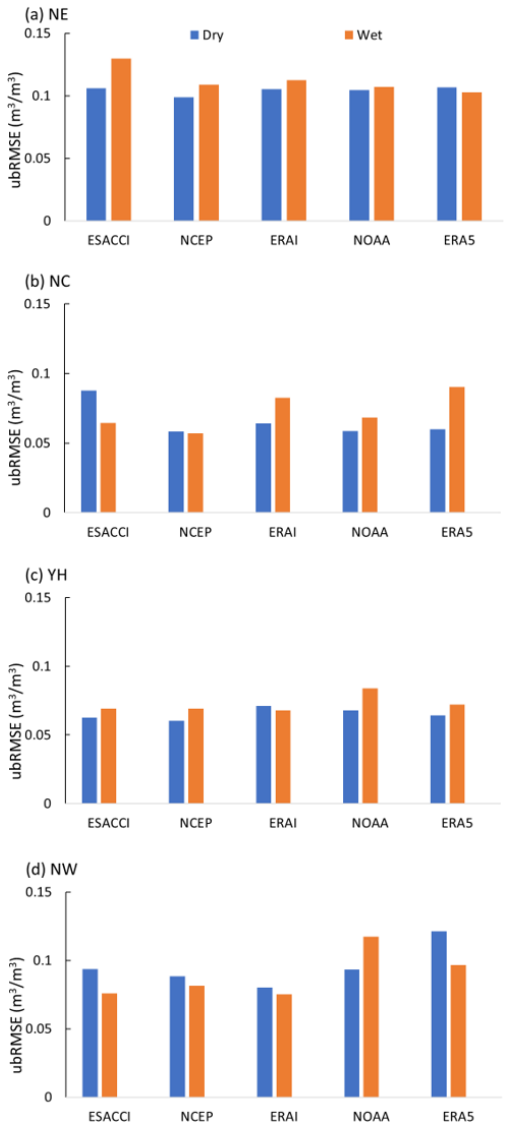
Figure 11. The ubRMSE of remote sensing and reanalysis SM against in situ observations under dry or wet conditions in differ- ent regions. The dry condition consists of extreme (scPDSI < − 4) and severe (scPDSI < − 3) drought conditions; the wet condition consists of extreme (scPDSI > 4) and severe (scPDSI > 3) wet spell